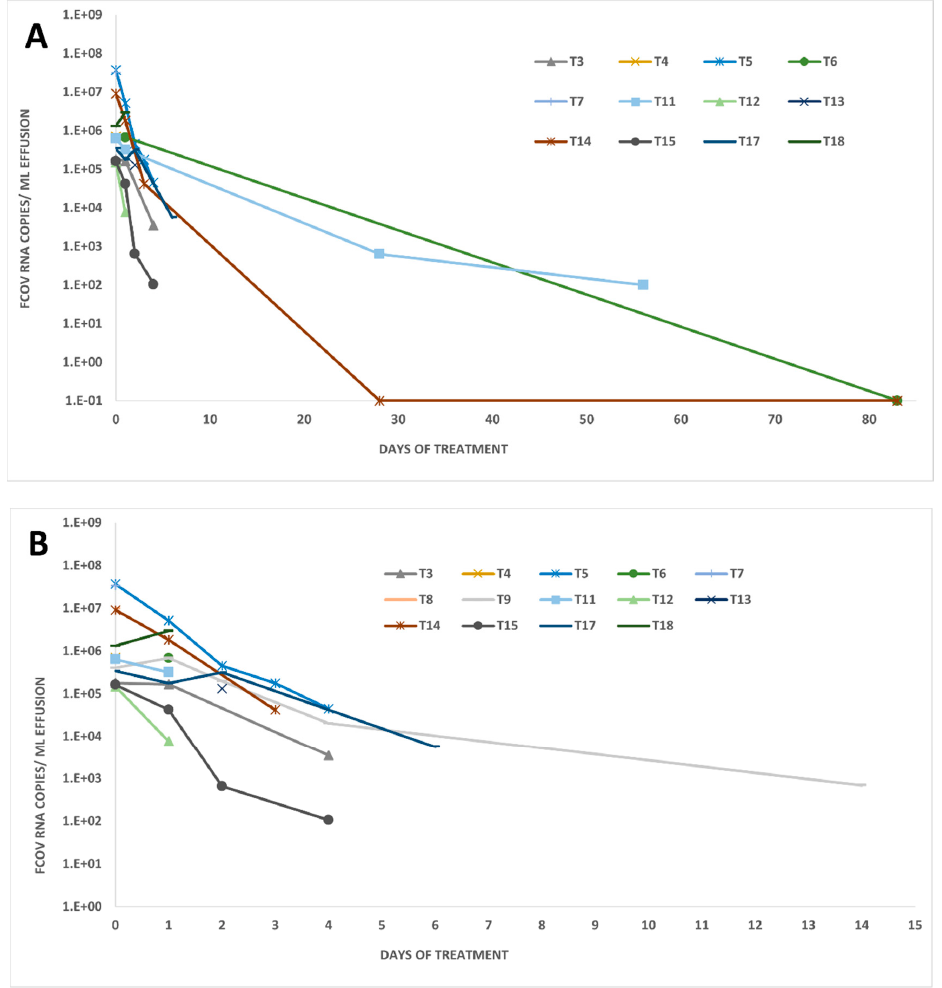
Figure 4. Viral RNA loads in accessible effusions of treated FIP cats. Present and accessible thoracic and abdominal effusions were collected ( A ): on days 0, 2, 4, 7, 14, 28, 56, and 83 and ( B ): on days 0, 2, 4, 7, and 14 for viral RNA load determination. Loads were measured by feline coronavirus (FCoV) quantitative reverse transcription polymerase chain reaction (RT-qPCR) in cats with accessible effusions ( n = 16). Values are given in copy numbers per mL effusion. When no value is depicted, either effusions were not (or no longer) accessible or no effusion was present.